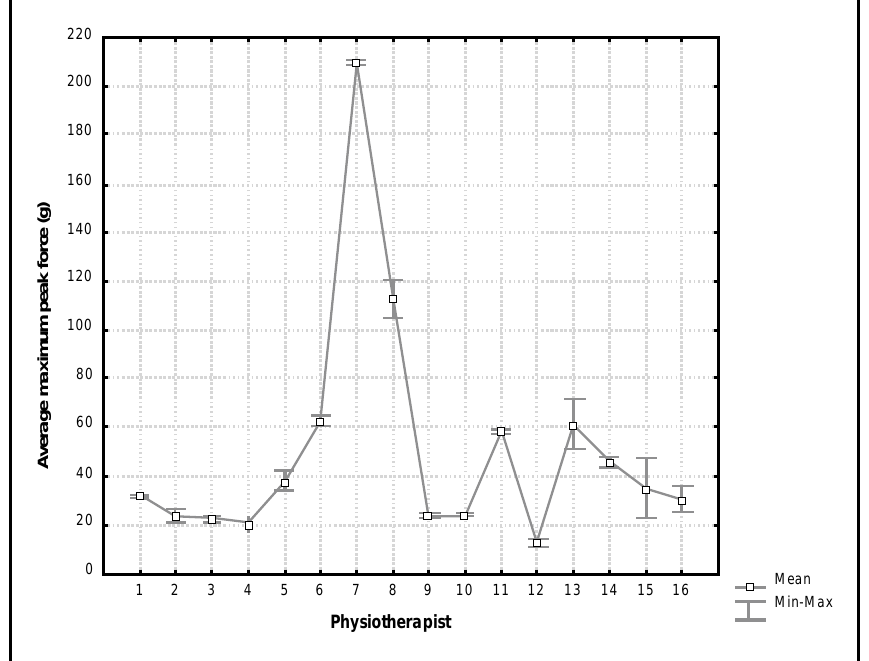
Figure 1: The average maximum peak force applied by each physio- therapist during a grade I p-a passive mobilization technique on C6, for measurement one and two, as well as the mean for both measurements.